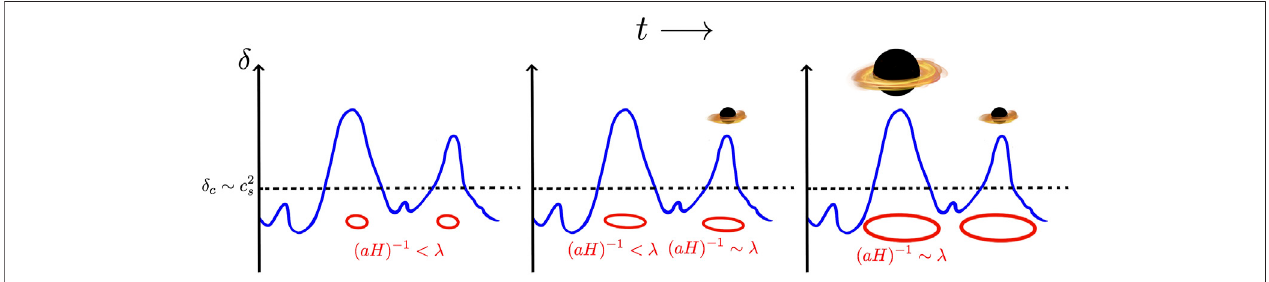
FIGURE 1 | Sketch of the formation of PBHs from overdensities for three different successive moments. When fl uctuations larger than a critical threshold δ c ∼ c 2 s enter the horizon, i.e., their wavelength λ (cid:1) 2 π / k (which characterizes the size of the perturbation) is of the order of the Hubble horizon ( aH ) − 1 , the overdense region collapses and a PBH is produced. As can be seen in Eqs 1 , 2 , longer modes (large λ , low k ) enter the horizon later and lead to more massive